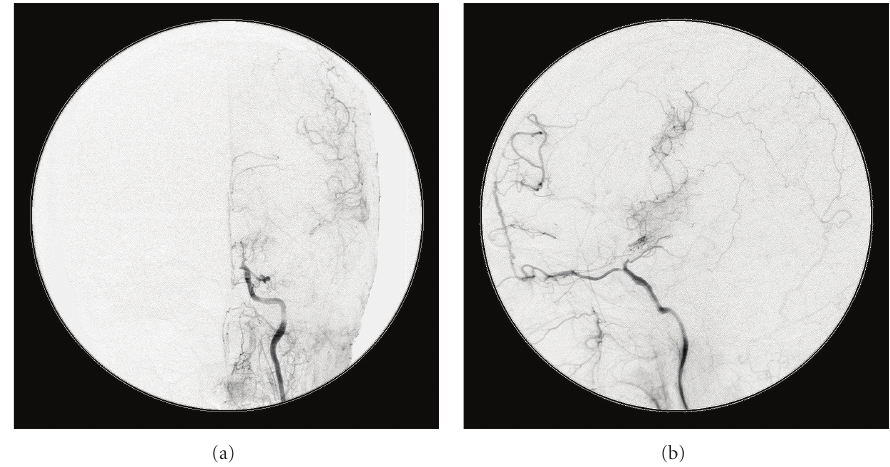
Figure 5: Postoperative digital subtraction angiography. Anteroposterior view (a) and lateral view (b) of the left common carotid angiogram indicating marked neovascularization from the graft compared with preoperative angiography (Figures 3(b) and